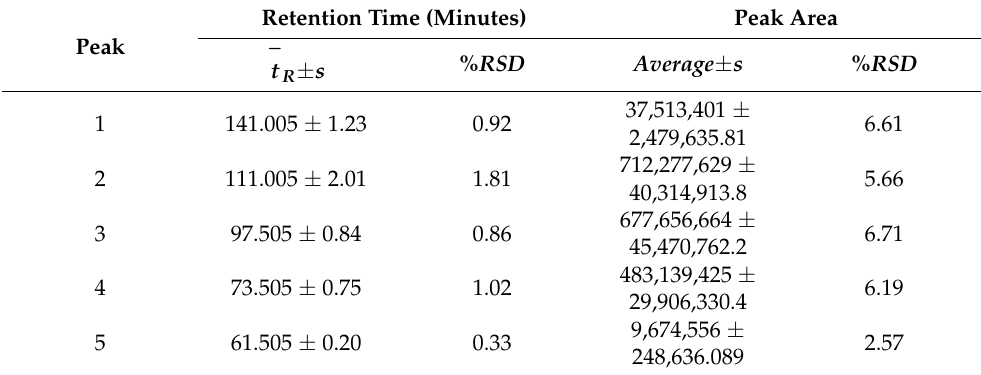
Table 2. Inter-day variabilities for TAGs retention times * and peak areas (three injections).